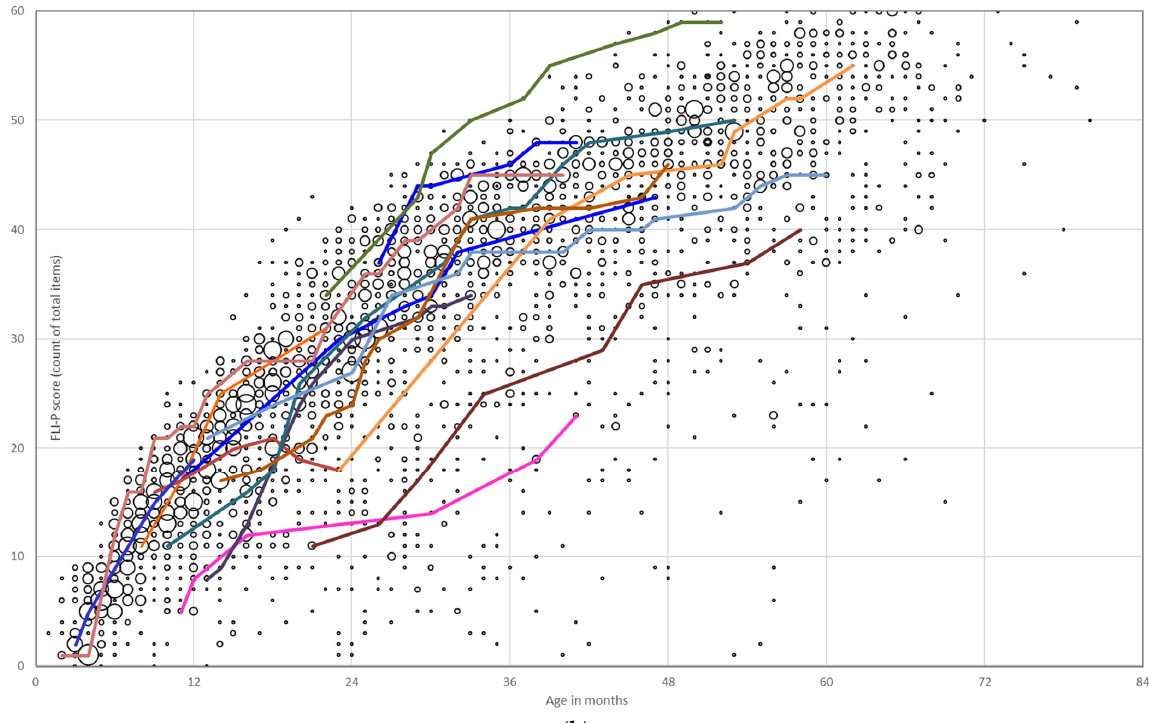
Figure 5. Individual trajectories of FLI-P scores for children with ( a ) bilateral ANSD and ( b ) unilateral ANSD. Results show a range in listening skill development as expected with ANSD. Increases in listening skills are evident post cochlear implantation (large dots). Each of the colored lines represents an individual child’s trajectory to highlight progress and different listening development